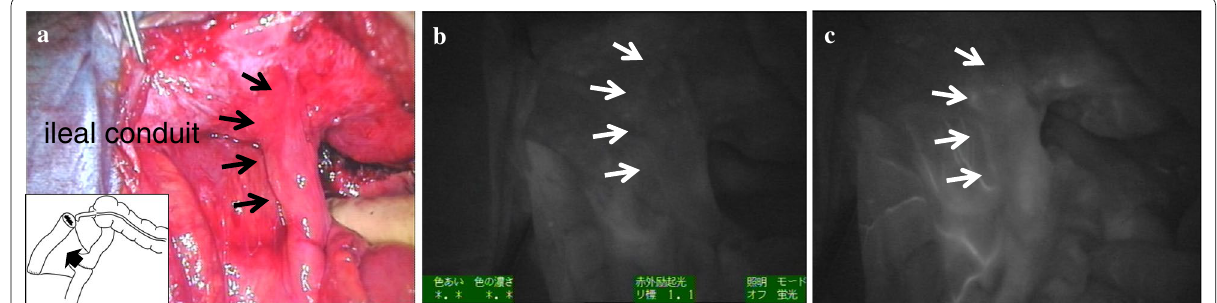
Fig. 4 Assessment of bowel perfusion after removal of the ileocecum and ascending colon including the ileal anastomotic site. Bowel perfusion under normal light ( a ), and under ICG fluorescence imaging before ( b ) and after ( c ) intravenous injection of ICG. Brightness of the ileal conduit after intravenous re-injection of ICG ( c ) was enhanced as compared to before fluorescence ( b )